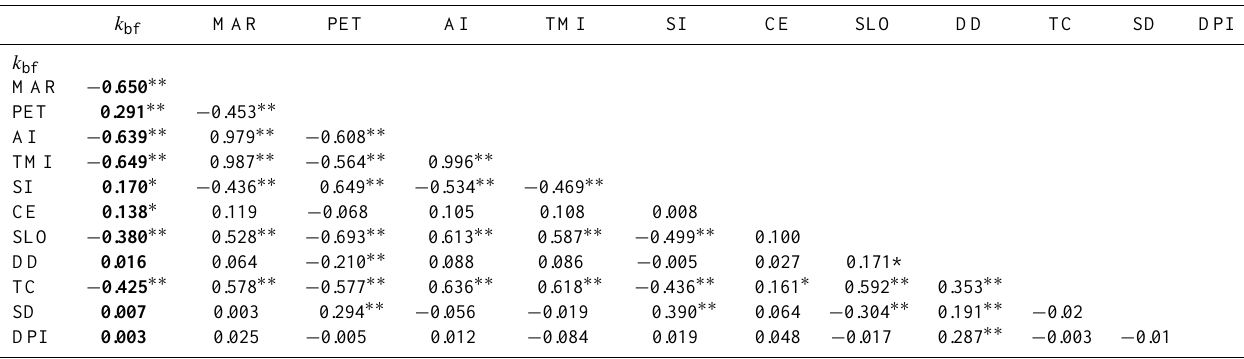
Table 2. Spearman rank correlation matrix of recession coefficients and catchment attributes. k bf correlations with climatic and catchment attributes are shown in bold.